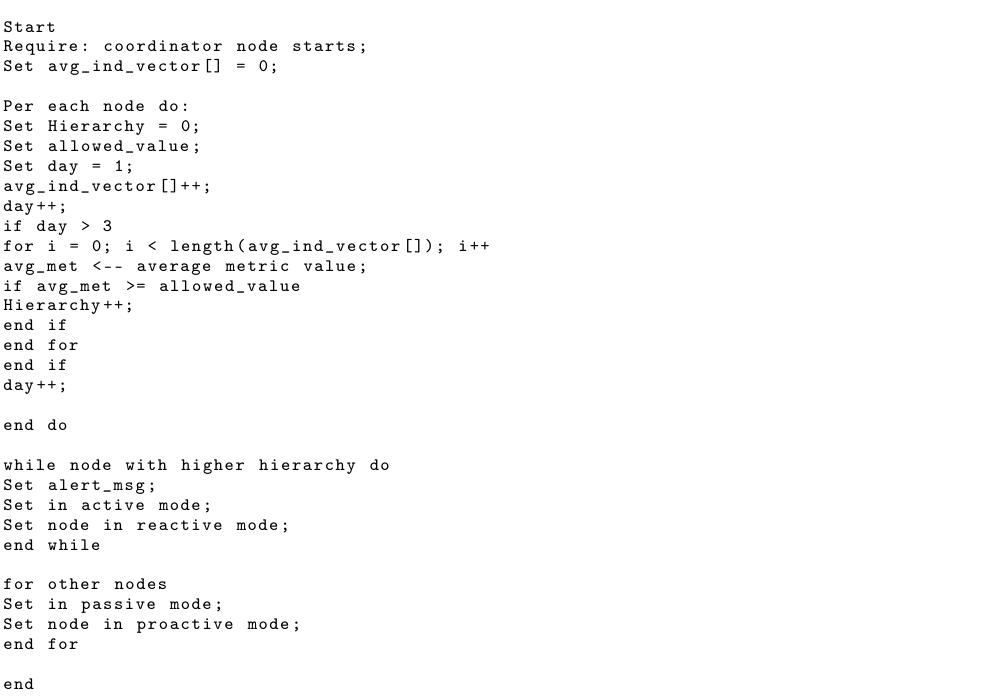
Algorithm 1 Pseudocode of the proposed